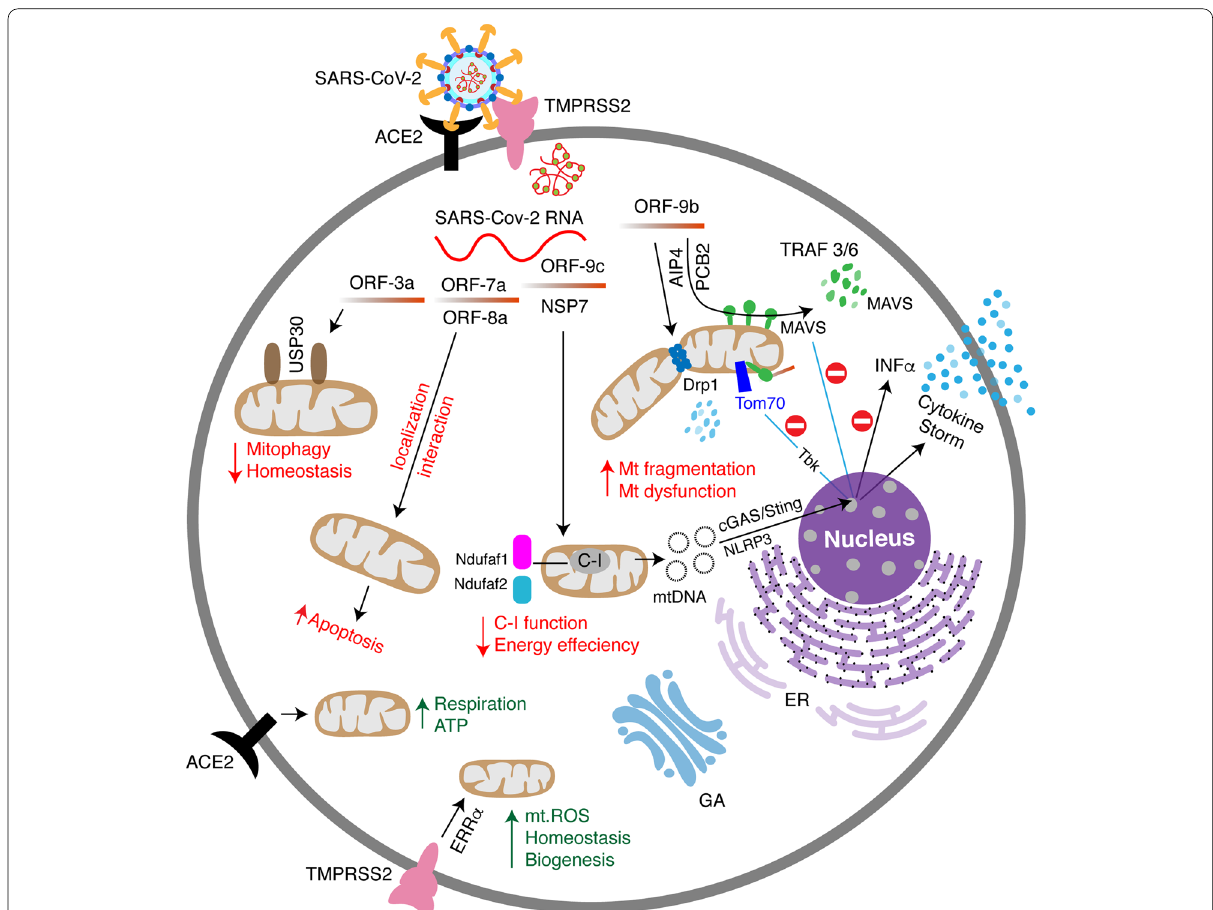
Fig. 3 SARS-CoV-2 entry and its interaction within mitochondria. Upon SARS-CoV-2 entry, RNA genome is released, translated, and the resulting structural and non-structural proteins interact with various mitochondrial components, leading to altered host mitochondrial function. Such interactions are necessary to hijack the mitochondria so that SARS-CoV-2 escape from mitochondria-mediated innate immune response and establish its